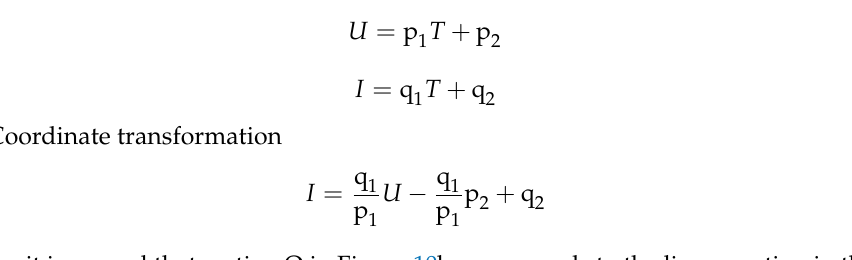
Table 3. Simulation data of the hot-spot control algorithm under different β . Shadow Occlusion